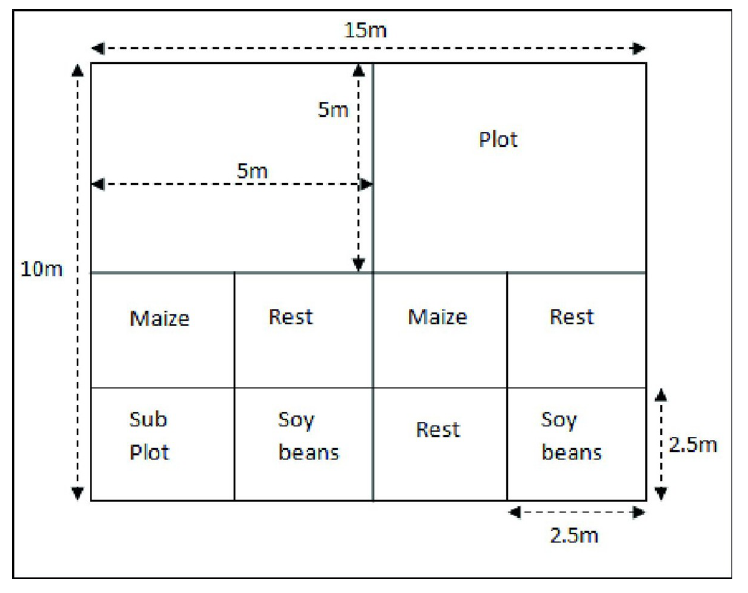
Fig 1. Experiment